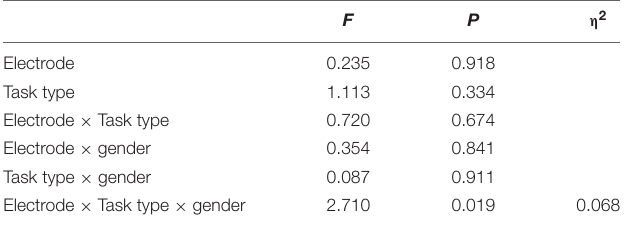
TABLE 2 | Results of dFRN Analysis.